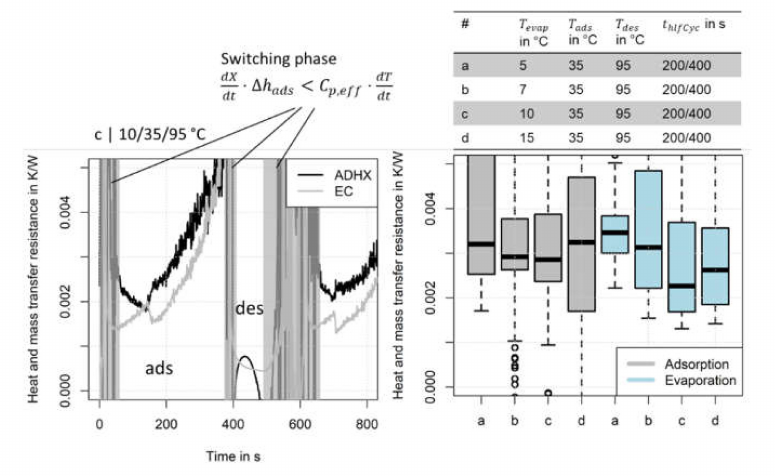
Figure 16. Time-dependent curves for heat and mass transfer resistances for measurement “c” 10/35/95 ◦ C, 200/400 s half cycle time ( left ), boxplot of heat and mass transfer resistances dur- ing adsorption/evaporation half cycle for measurements with different evaporator temperatures ( right ). The overall heat and mass transfer resistance of the ADHX is not affected by the different evaporator temperatures.